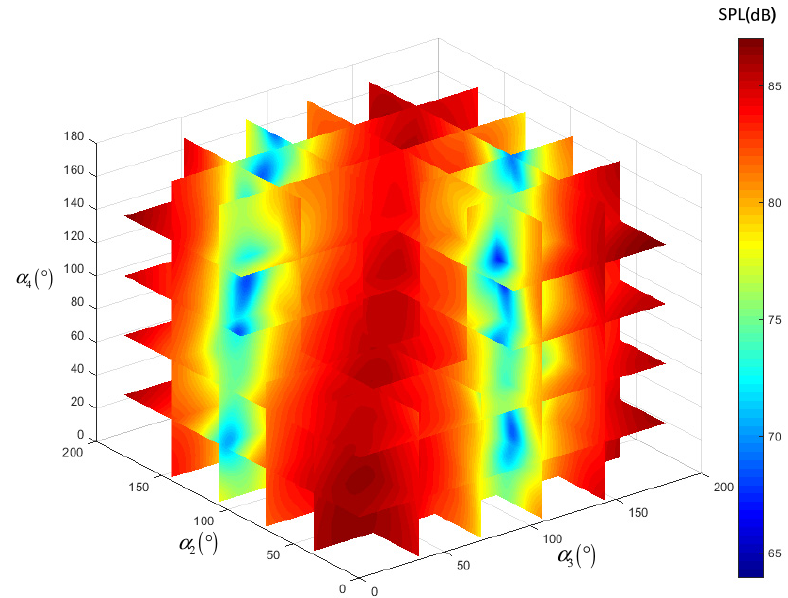
Figure 4. SPL changes with { 0 ◦ , α 2 , α 3 , α 4 } .